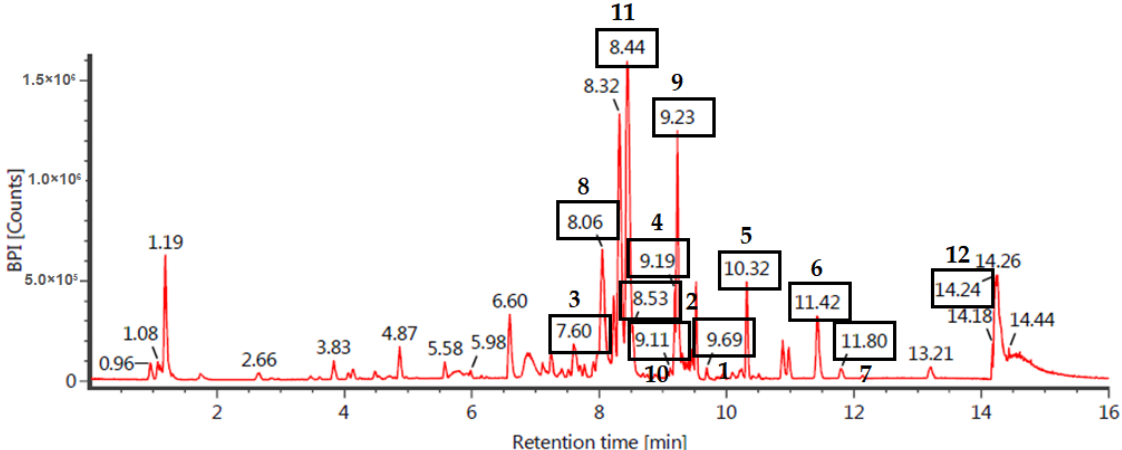
Figure 1. Alkaloids and flavonoids content in A. muricata leaf ethanol extract.